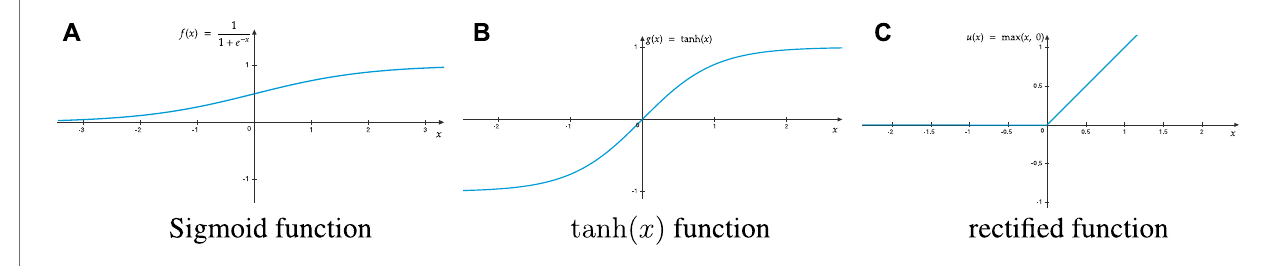
FIGURE 4 | Three indicative examples of commonly used activation